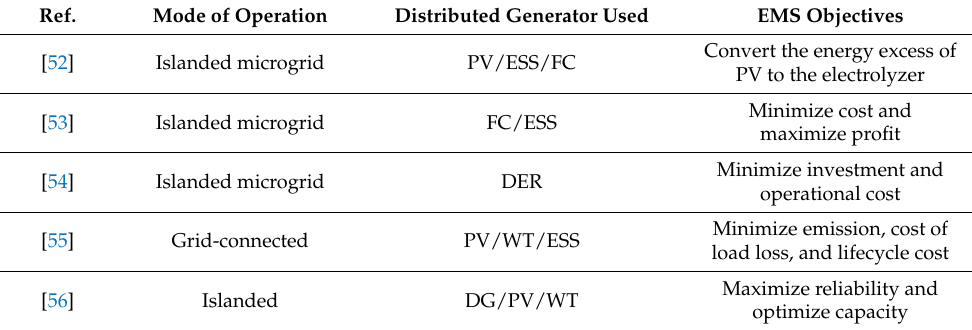
Table 6. Objectives of the energy management system for a microgrid.